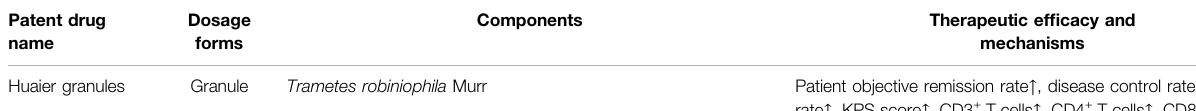
TABLE 1 | Chinese patent medicines used to treat PLC. Patent drug